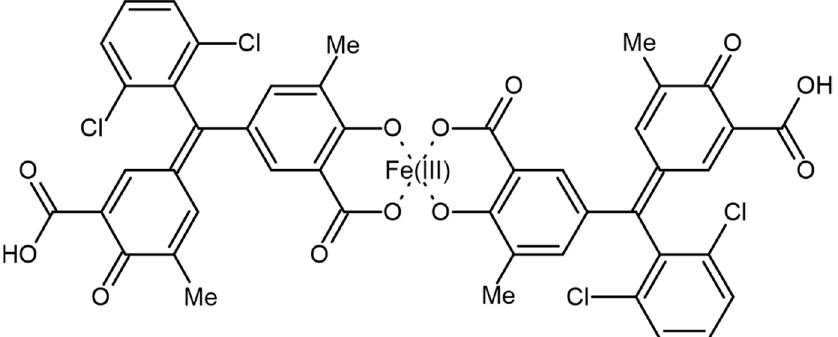
Figure 8. Structure of chromazurol S complex with Fe(III).